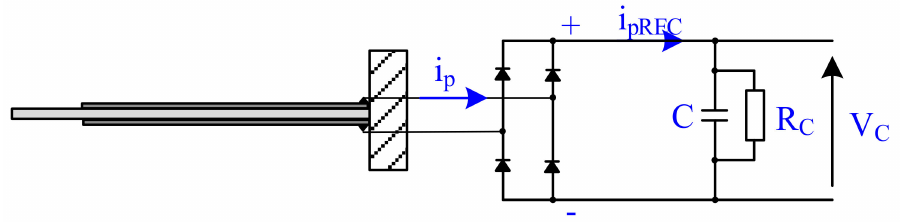
Figure 5. Parallel resistance in energy storage